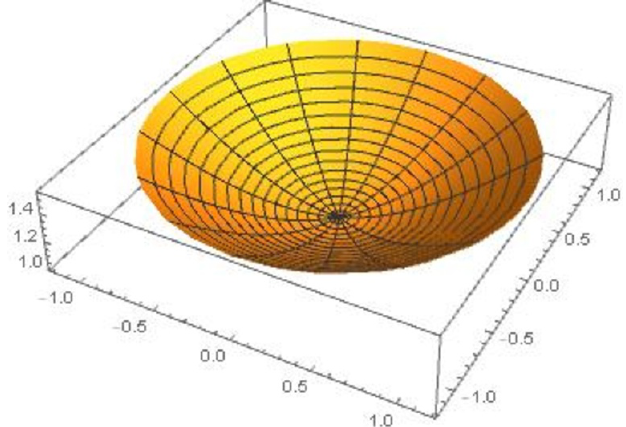
Figure 1 . Hyperbolic space with a boundary circle.